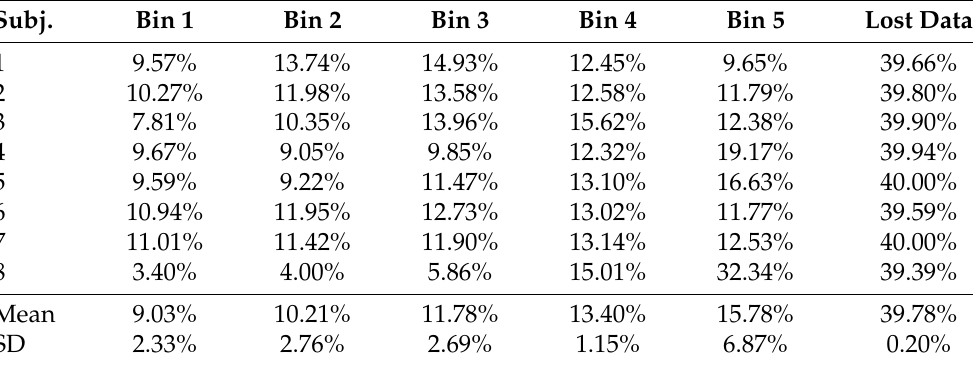
Table 5. Gating statistics in the PET images with respiratory motion-compensated reconstruction based on the MMS respiratory signal, compared to a non-gated reconstruction (100%). Lost data signifies the amount of data rejected due to cycle rejection and signal falling out of gating thresh- old bounds.